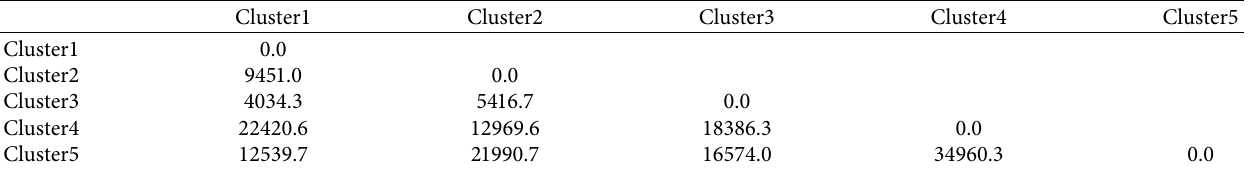
Table 5: Distance between cluster centroids.